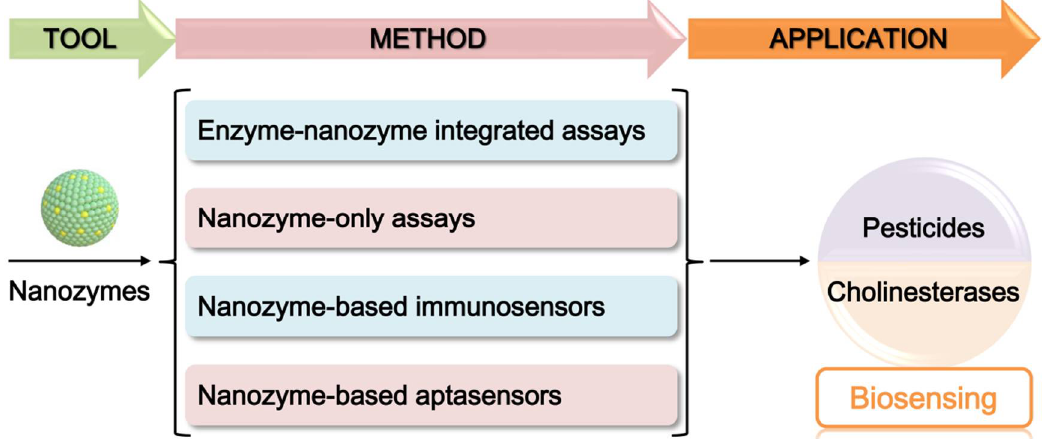
Figure 1. Schematic diagram of nanozymes as an emerging tool to develop various methods for biosensing of pesticides and cholinesterases.